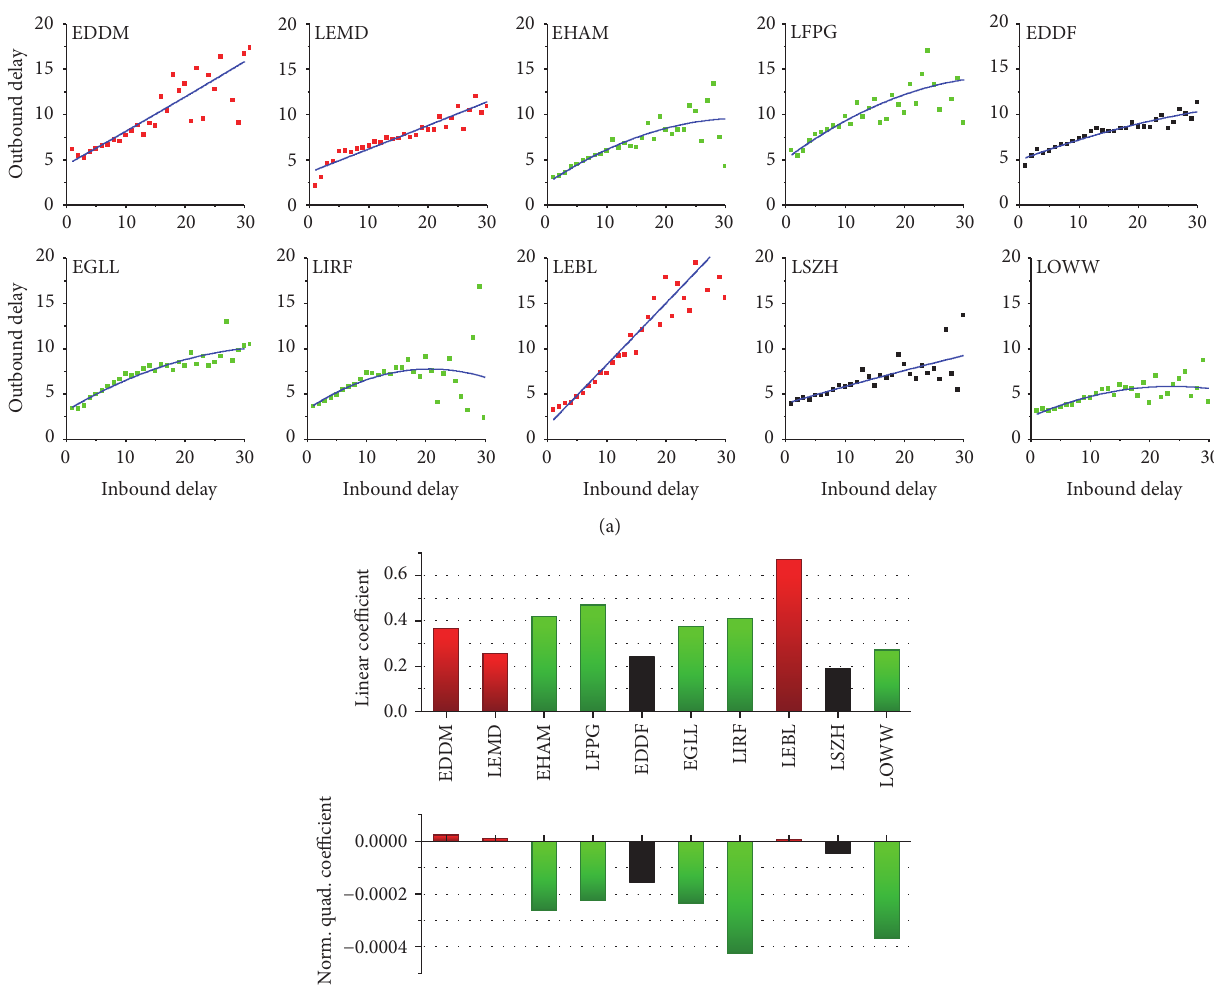
Figure 3: Behaviour of the top 10 European airports for a phase of one hour. Panels and colours represent the same information as in Figure